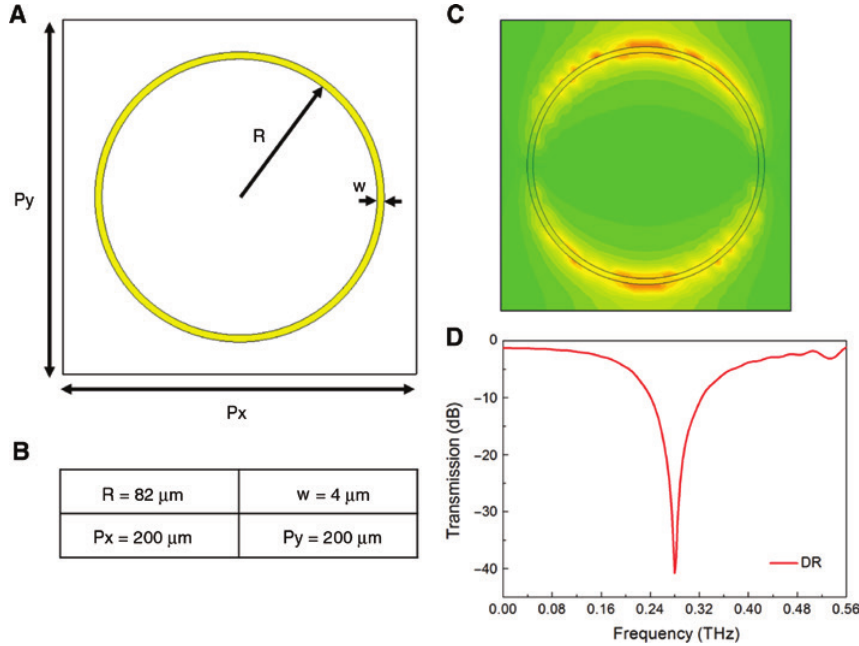
Appendix-Figure 3: Simulation detail of DR: (A) 2D structure model, (B) structural parameters, (C) electrical field distribution, and (D) transmission spectrum.